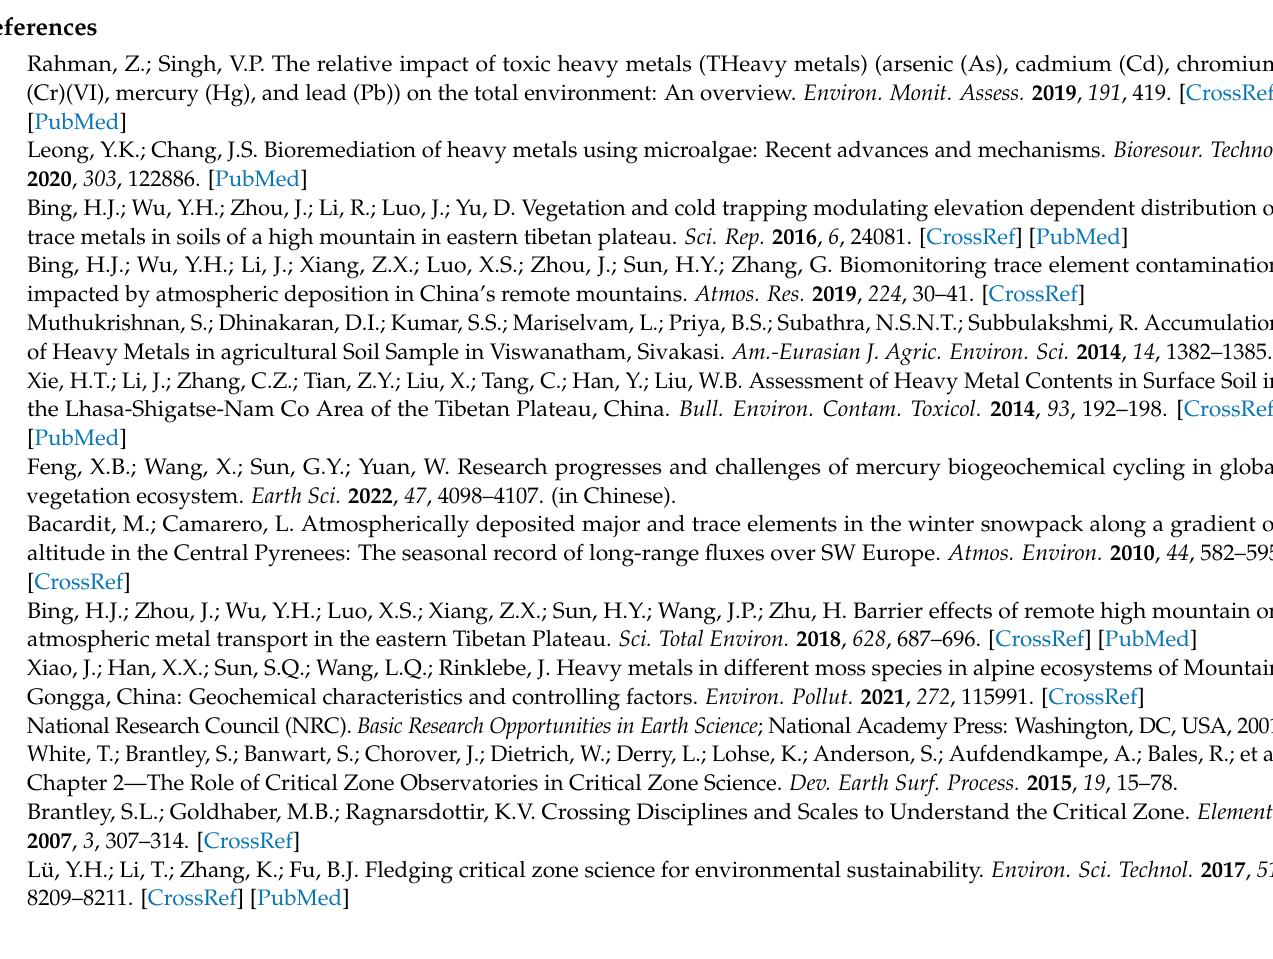
Table S1: Quality control of measuring metal(loid)s in the soil and moss samples; Table S2: The calculation methods and pollution level classification criterion for all the indexes of SNJ soil, moss, and water; Table S3: Descriptive statistics of metal(loid)s contents and chemical parameters in soil, moss, and